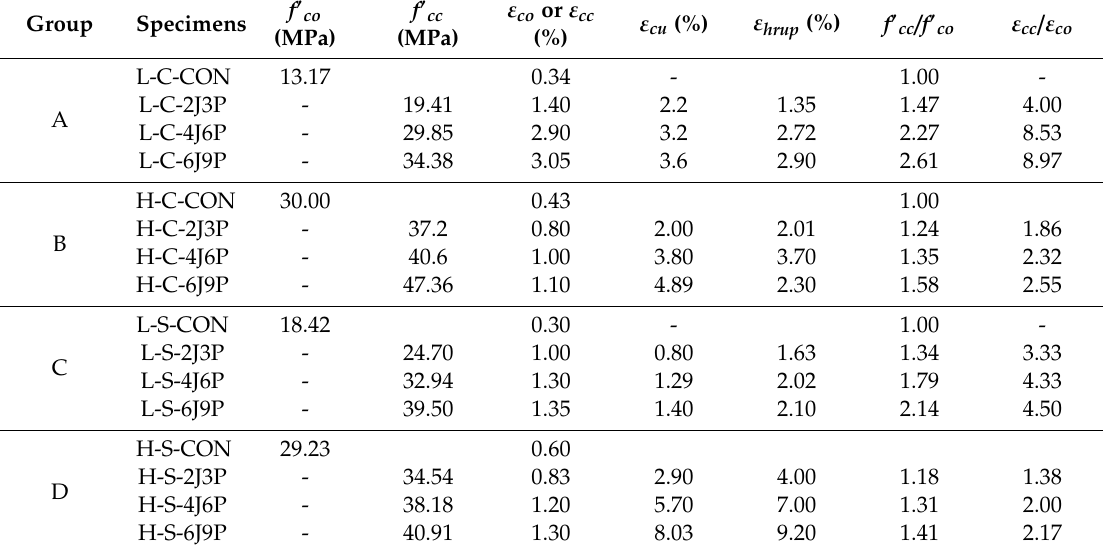
Table 6. Average values of tested